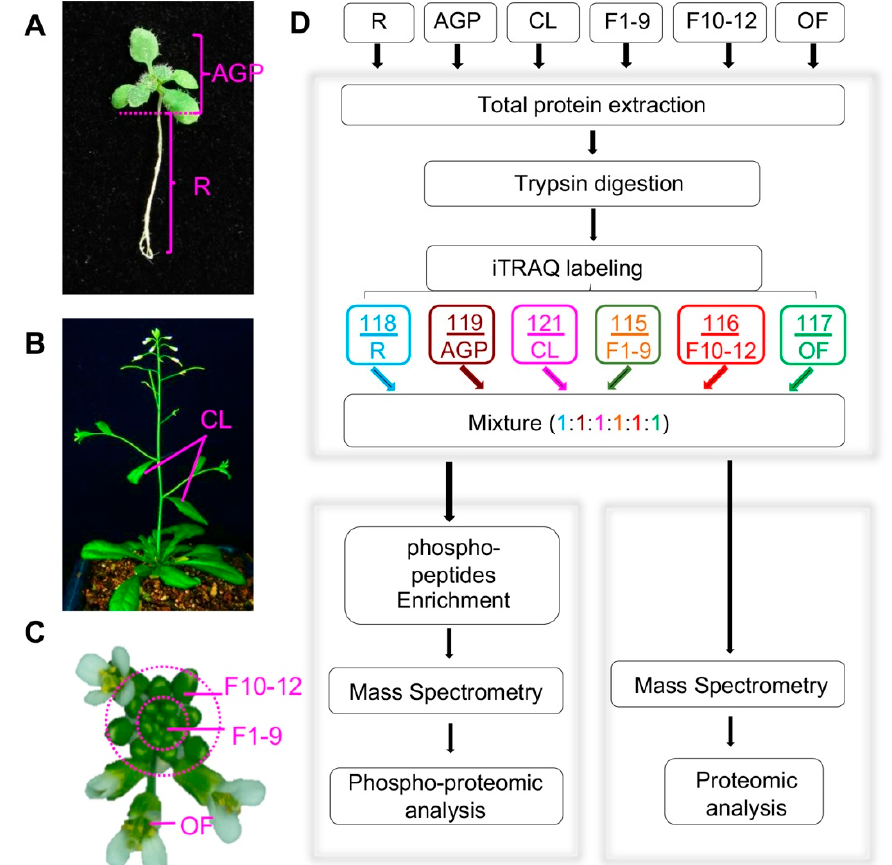
Figure 1. Plant tissue collection and the procedure for quantitative proteomics and phospho-proteomics analyses. ( A ) Above-ground parts (AGP) and roots (R) of 16-day-old plants. ( B ) Front view of plants during the flowering period, including cauline leaves (CL) and inflorescences (Flower). ( C ) Col-0 inflorescence including stage 1–9 flowers (F1–9), stage 10–12 flowers (F10–12), and open flowers (OF). ( D ) Workflow of our iTRAQ-based quantitative proteomics and phospho-proteomics analyses. The arrows represent experiment process.